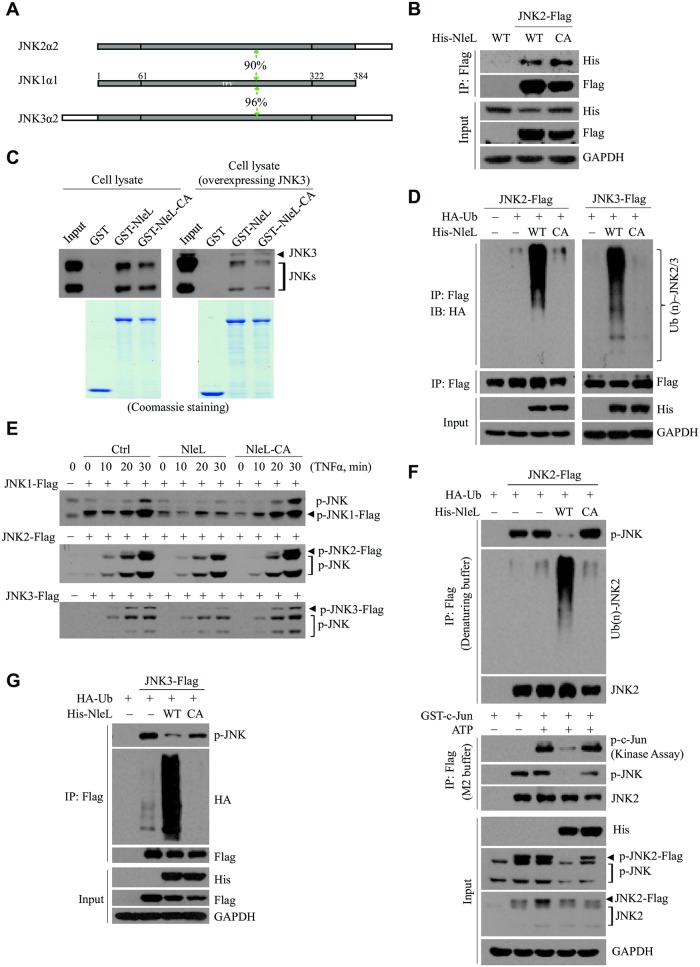
NleL targets other human JNK family proteins (JNK2 and JNK3).(A) A schematic view of the sequence homology between human JNK family proteins. The level of sequence homology between JNK1 and JNK2 or JNK3 (90% and 96%, respectively) is indicated. (B) NleL interacted with JNK2. Flag-tagged JNK2 and His6-tagged NleL (His-NleL) or C753A mutant (His-NleL-CA) were ectopically expressed in cells. Cells were lysed and subjected to Co-IP with anti-Flag beads, followed by IB analysis with indicated antibodies. (C) NleL interacted with endogenous JNKs or ectopically expressed JNK3. GST-tagged NleL, its C753A mutant or GST only was individually subjected to the GST pull-down assay with cell lysates of HEK293T cells transfected with (right) or without (left) Flag-tagged JNK3. The bound proteins were immunoblotted with anti-JNK antibody. (D) NleL promotes ubiquitylation of JNK2 (left) or JNK3 (right) in vivo. (E) NleL blocked TNFα-induced JNK1, JNK2 or JNK3 phosphorylation. HEK293T cells expressing Flag-tagged JNK1, JNK2 or JNK3 and His6-tagged wild-type NleL or its C753A mutant were subjected to TNFα treatment (10 ng/ml) at indicated times. Phosphorylation status of JNKs was determined by IB analyses with anti-p-JNK. (F and G) NleL-associated JNK2/3 ubiquitylation conversely correlates with the phosphorylation of JNK2/3. Phosphorylation and ubiquitylation status of JNK2 (F) or JNK3 (G) was assayed with Flag-JNKs enriched from cells expressing wild-type NleL or the C753A mutant, followed by immunoblotting analyses with indicated antibodies. The in vitro kinase assay was performed with Flag-tagged JNK2 (F). All the blots are representative of at least three independent experiments.